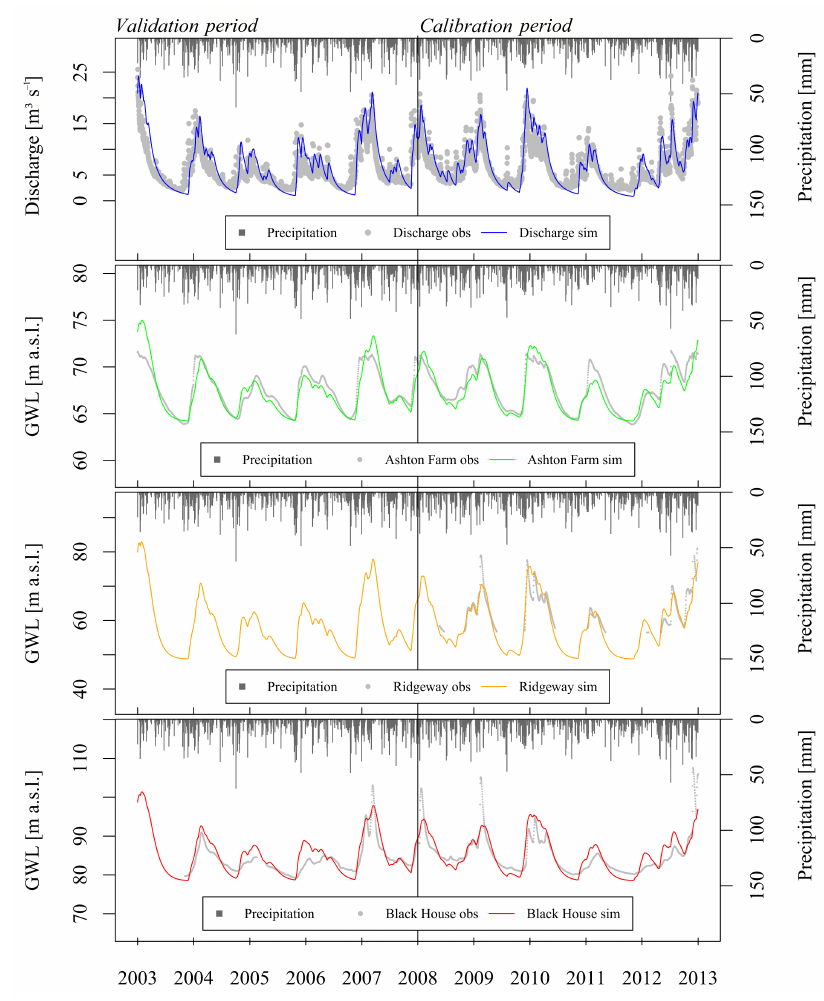
Figure 4. Modelled discharge (m 3 s − 1 ) and groundwater levels (ma . s . l . ) at the boreholes Ashton Farm, Ridgeway and Black